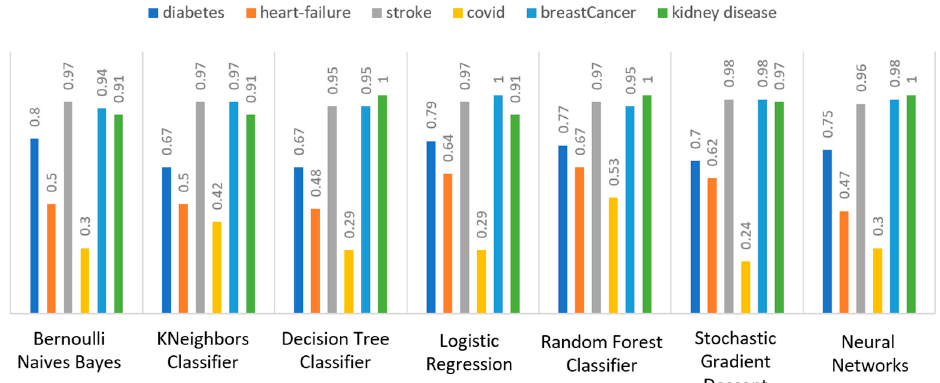
Figure 13. F1-score results of ML models for each use case.